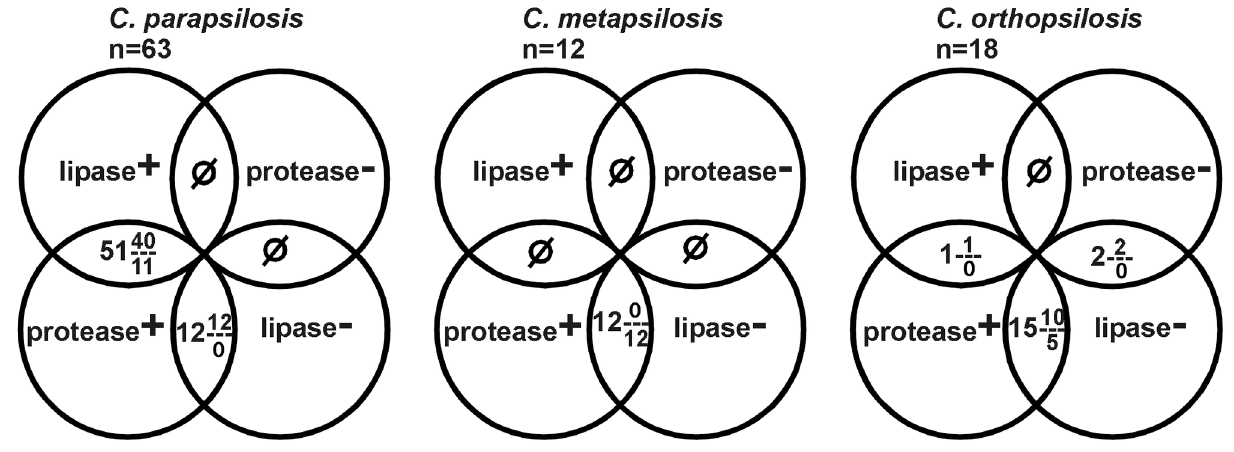
Figure 1. Diagrammatic presentation of the occurrence of lipase-, protease- and pseudohyphae-producer strains in the C. parapsilosis sensu lato complex. n: number of isolates, upper number in fraction: number of pseudohypha-producer strains, lower number in fraction: number of pseudohypha negative